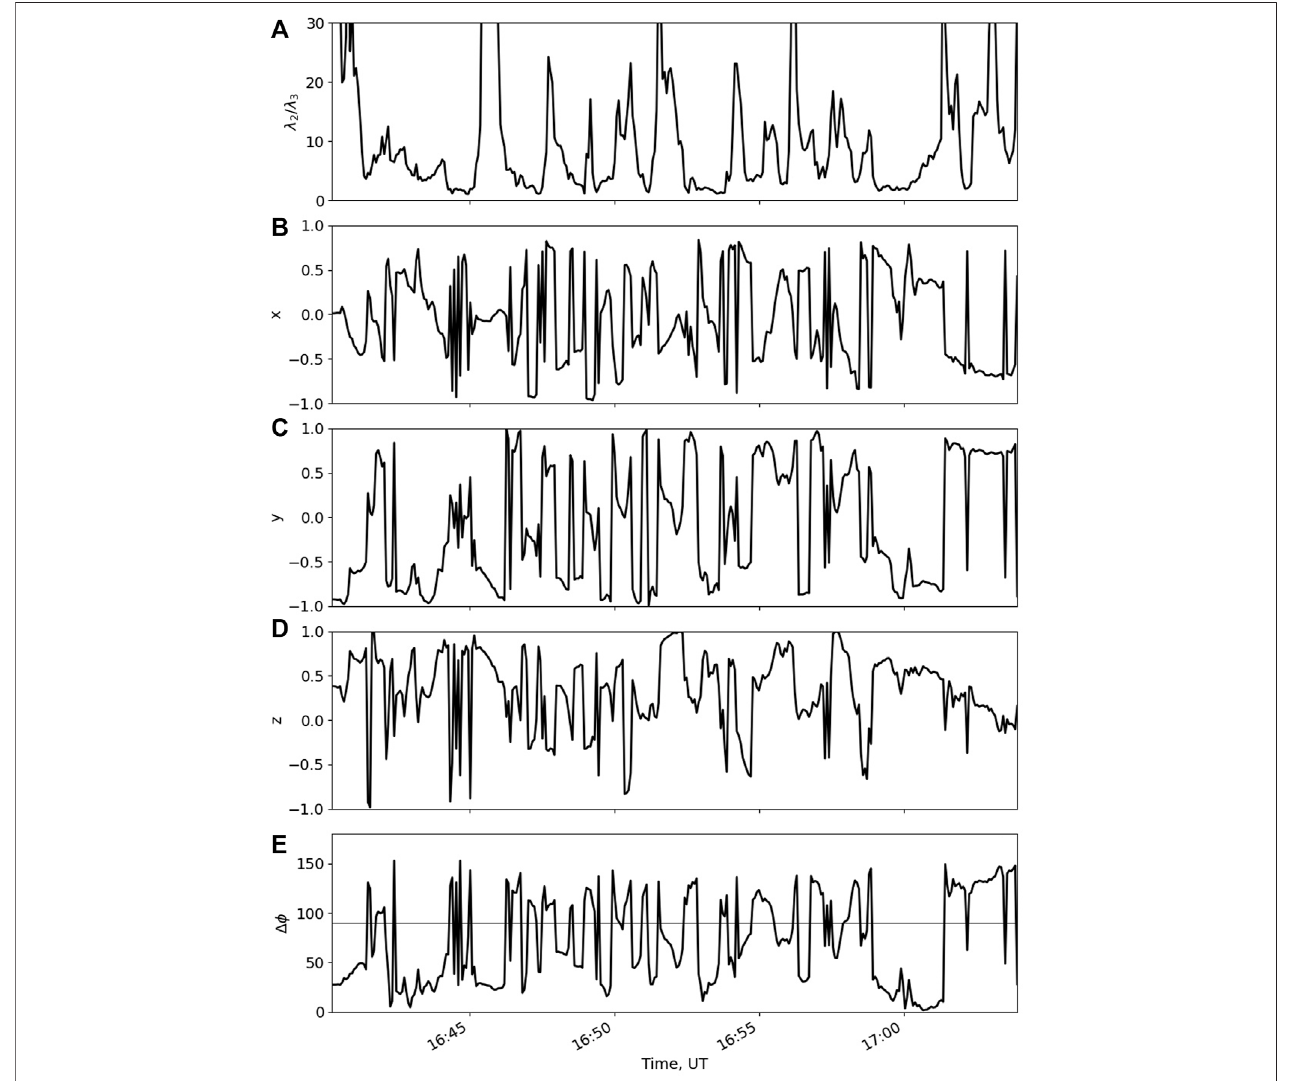
FIGURE 4 | SC 1 derived parameter pro fi les for the KHI event on July 3, 2007 are shown for the time frame of 1640 – 1705 UT. From top to bottom within each graph: (A) theratio λ 2 / λ 3 ; (B – D) X , Y ,and Z componentsofboundarynormals,respectively; (E) anglebetweenaveragenormalandindividualnormal.Theaveragenormal iscalculatedforthewholetimeintervalusingtheSiscoemethod.Theindividualnormalswerede fi nedsubsequentlyforeach1 minperiodofobservations.Thehorizontal line is at 90 °